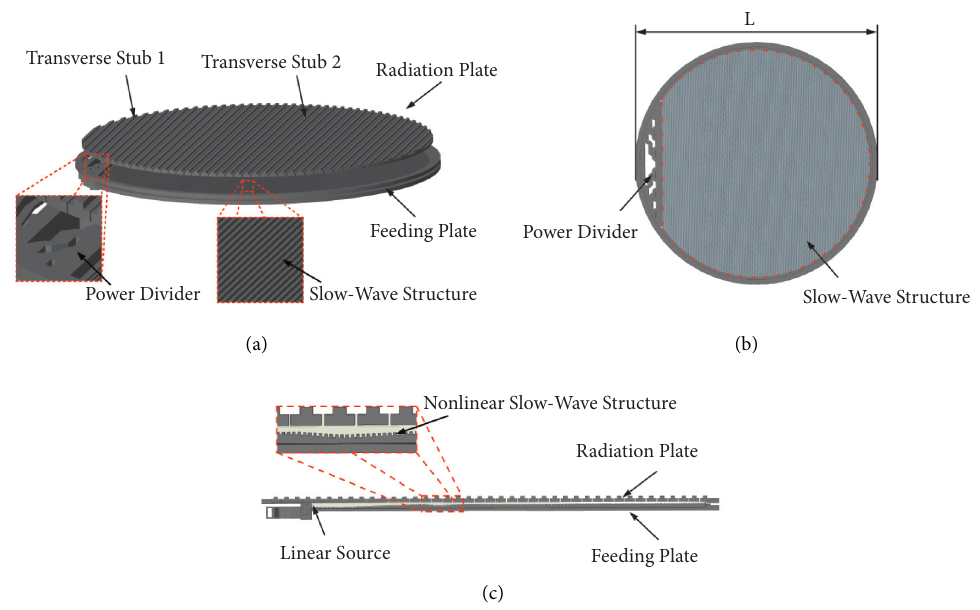
Figure 1: Overview of the VICTS antenna. (a) 3D view. (b) Top view of the feeding plate. (c) Sectional view.